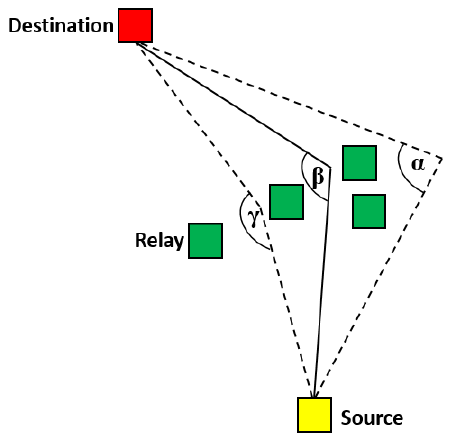
Figure 17. Base angle adjustment to alter flood area.